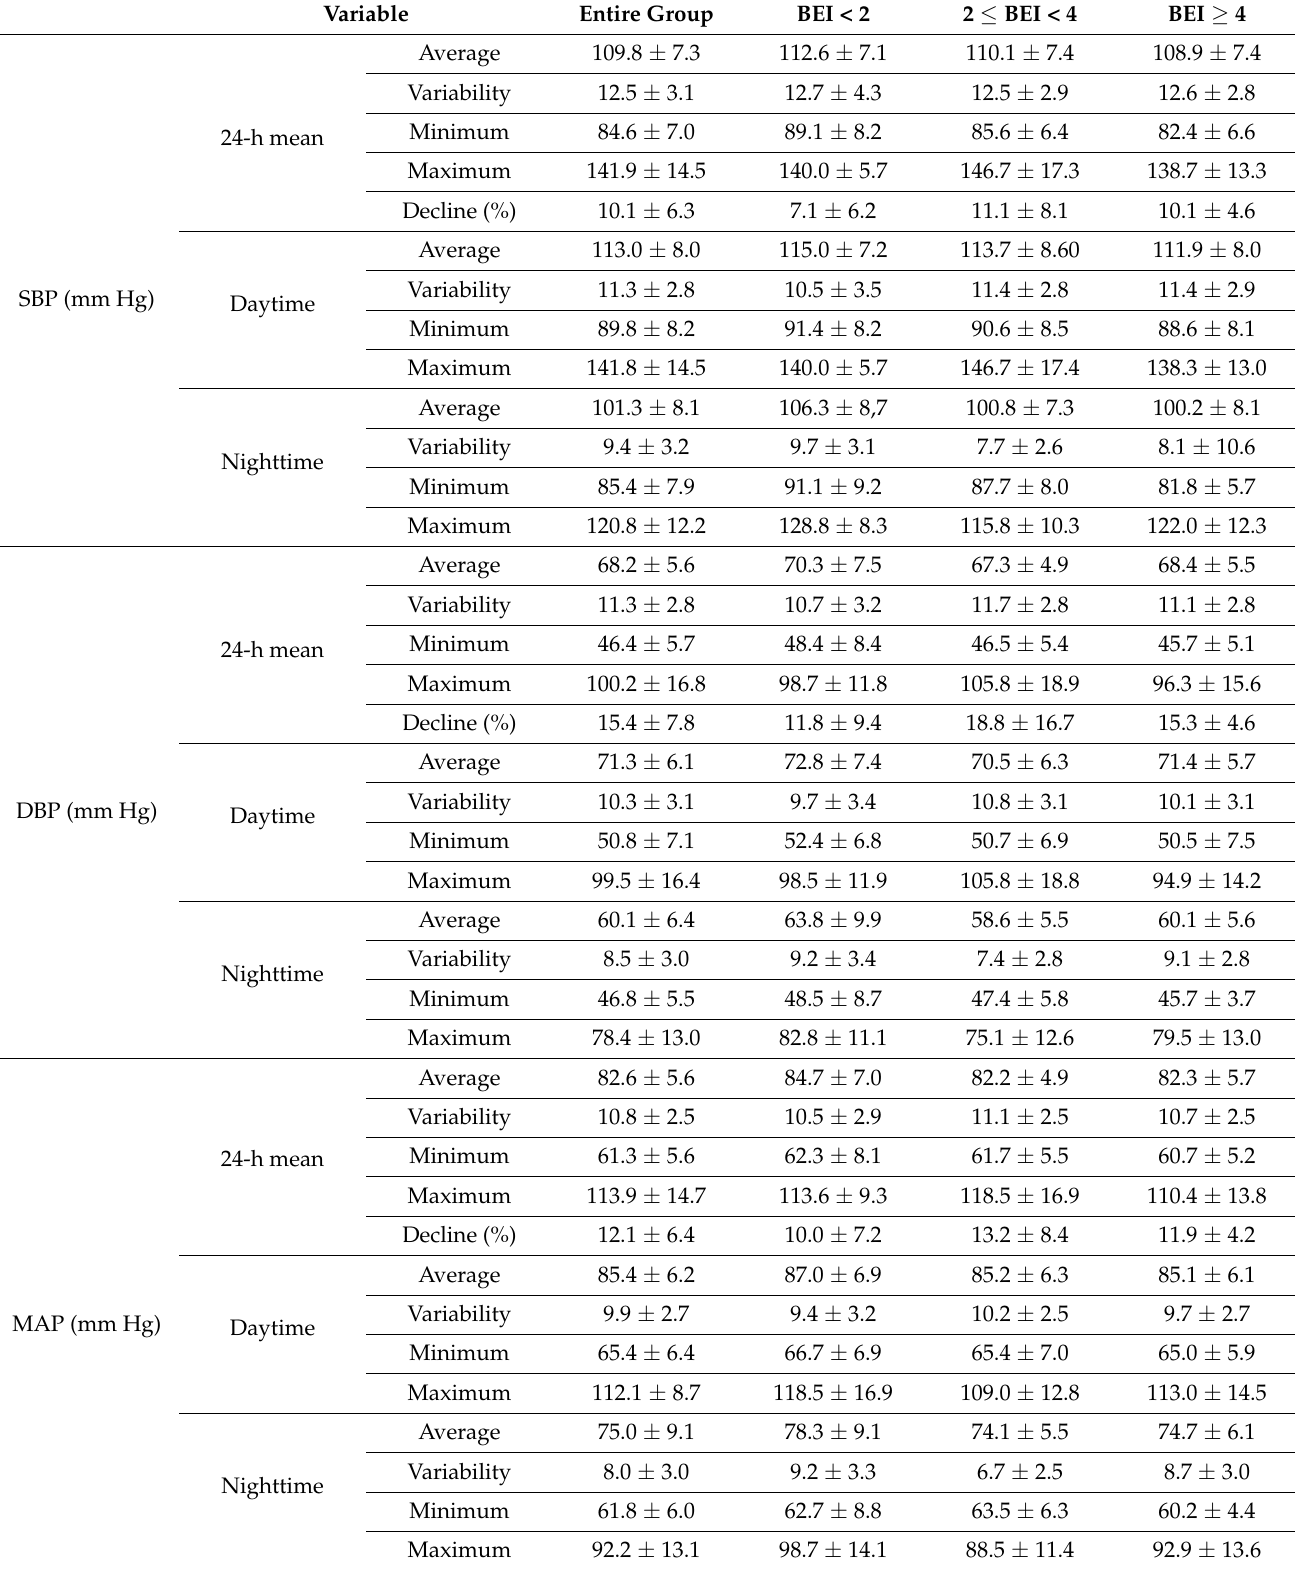
Table 3. Ambulatory BP characteristics of the entire study group and the